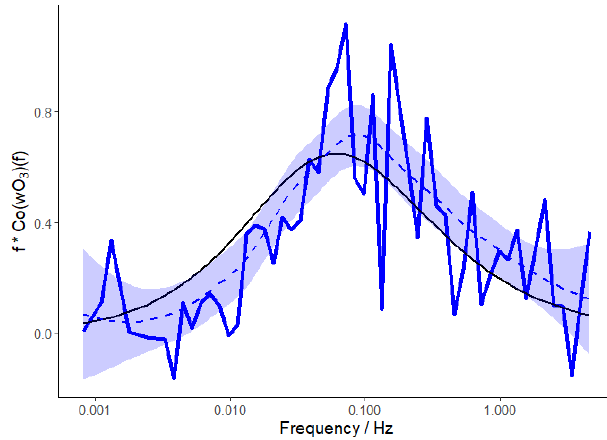
Figure 11. Average ozone flux co-spectrum for the 17 April, nor- malised to area = 1, shown in blue with a smoothed local regression (LOESS, dashed line) and 95% confidence interval (blue shading). Wind speeds were 10.3–12.3ms − 1 , and dimensionless Obukhov lengths were 0.14–0.17, representing near-neutral, slightly stable conditions. Expected co-spectral shape predicted by Kaimal et al. (1972) shown in